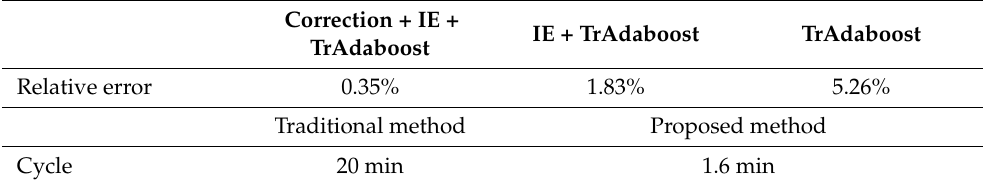
Figure 10. The performances of the prediction model without KAFPs selection. (( a ) EVS ; ( b ) R 2 ; ( c ) MSE; ( d ) MAE). Table 7. The experimental analysis